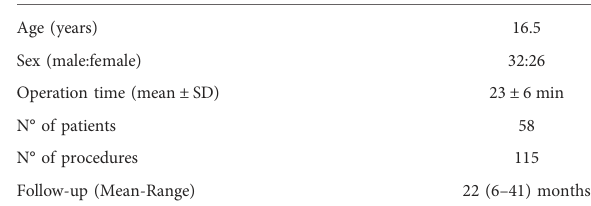
TABLE 1 Characteristics of patients. Characteristics of